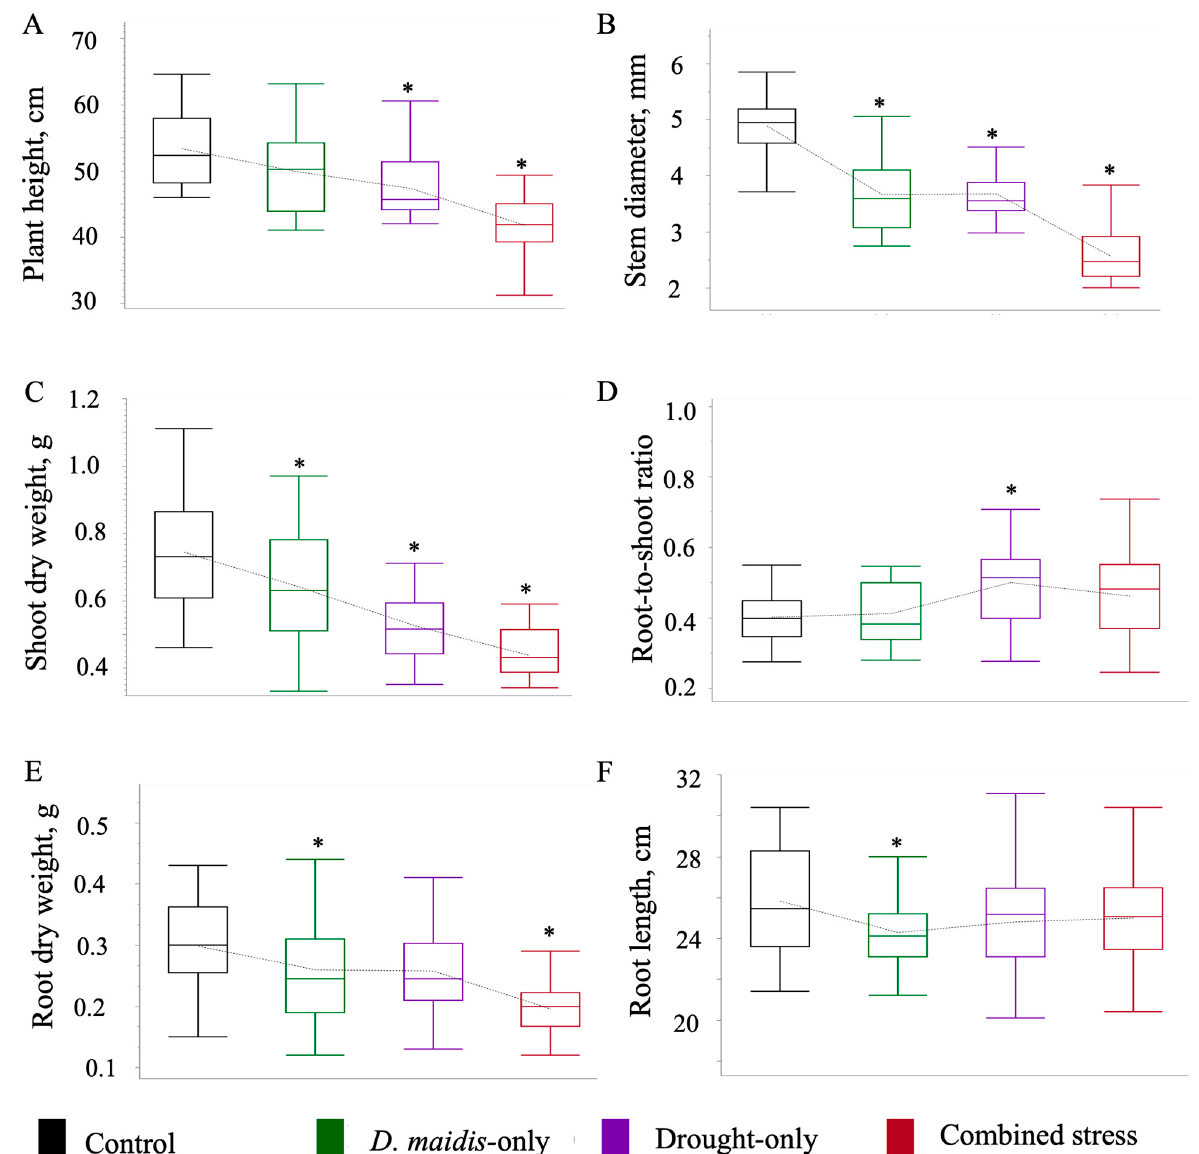
Figure 2. Effects of drought, Dalbulus maidis , and combined stress on drought-tolerant maize hybrids. ( A ) plant height [Drought F 1,1 = 45.579 p , < 0.0001; D. maidis F 1,1 = 17.910 p , < 0.0001; drought × D. maidis F 1,1 = 1.0660 p , = 0.304], ( B ) stem diameter [Drought F 1,1 = 128.838 p , < 0.0001; D. maidis F 1,1 = 137.440 p , < 0.0001; drought × D. maidis F 1,1 = 0.456 p , = 0.50], ( C ) shoot dry weight [Drought: F 1,1 = 67.837 p , < 0.0001; D. maidis F 1,1 = 16.540 p , < 0.000; drought × D. maidis F 1,1 = 0.253 p , = 0.616], ( D ) root-to-shoot ratio [Drought: F 1,1 = 16.708 p , < 0.0001; D. maidis F 1,1 = 0.936 p , = 0.336; drought × D. maidis F 1,1 = 1.234 p , = 0.269], ( E ) root dry weight [Drought F 1,1 = 16.260 p <0.0001; D. maidis F 1,1 = 20.755 p , < 0.0001; drought × D. maidis F 1,1 = 0.424 p , = 0.517], and ( F ) root length [Drought F 1,1 = 0.018 p , = 0.895; D. maidis F 1,1 = 3.747 p , = 0.056; drought × D. maidis F 1,1 = 5.283 p , = 0.024]. Treatment groups are ordered from left to right by control, D. maidis -only, drought-only, and combined stress treatments. Asterisks indicate significant differences between control and treated seedlings per Dunnett’s tests (statistics are shown in Table 1). Box plots represents mean values from all three drought-tolerant hybrids (LH195 × TX772, LH195 × TX773, and TX790 × TX777).